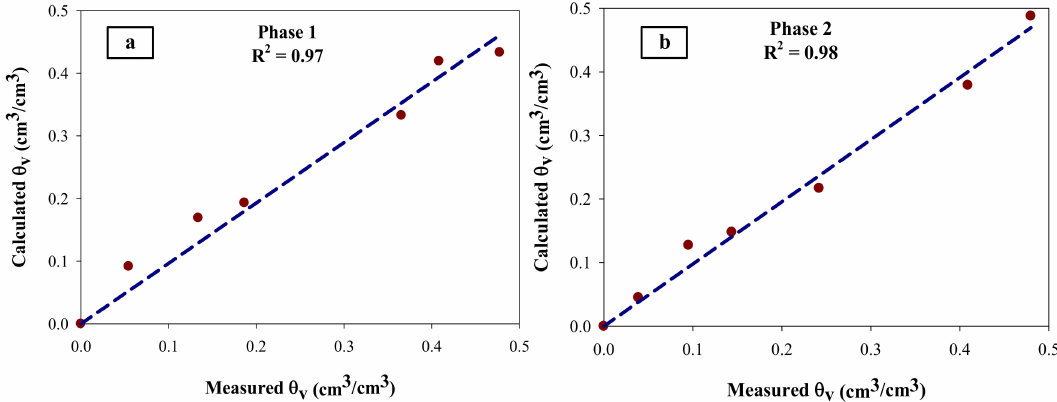
Figure 4. Comparison between measured and calculated volumetric water content for Sensor 4 for ( a ) before all experiments, phase 1, and ( b ) after six experiments, phase 2. A 0.78 m 3 (15 ft 3 ) chest freezer (120.3 × 76.8 × 84.8 cm, MAYTAG, Benton Harbor, MI, USA)